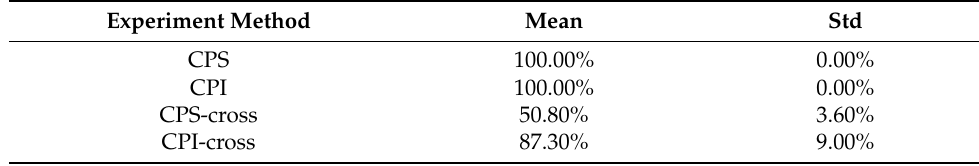
Table 6. Evaluation of test results for each